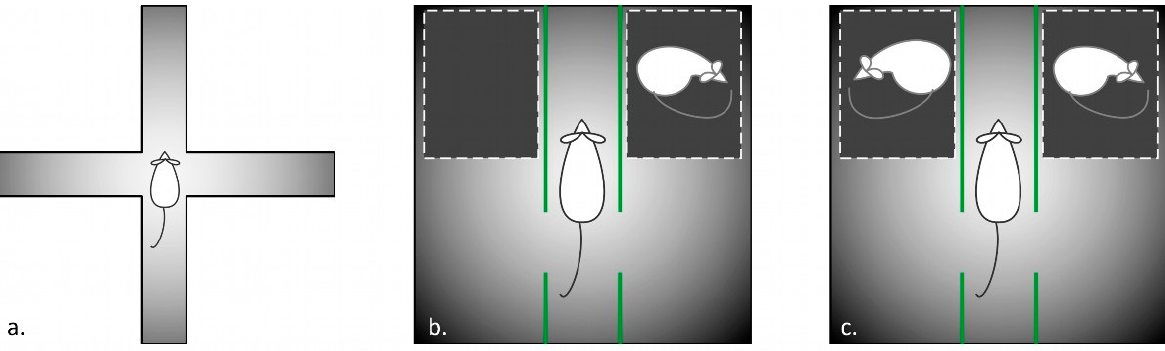
Figure 1. Schemes of experimental setup: ( a ) elevated plus maze; ( b ) three-chambered social prefer- ence test; ( c ) three-chambered social novelty test.